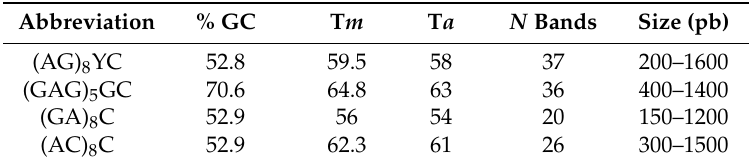
Table 2. ISSR primers screened for ISSR-PCR in Eunica tatila . Percentage of guanine and cytosine content (%GC), melting temperature (T m ), annealing temperature (T a ), total number of bands per primers over all localities ( N bands), size of the DNA fragments for each primer (size). The following designation was used for degenerated sites: Y (C or